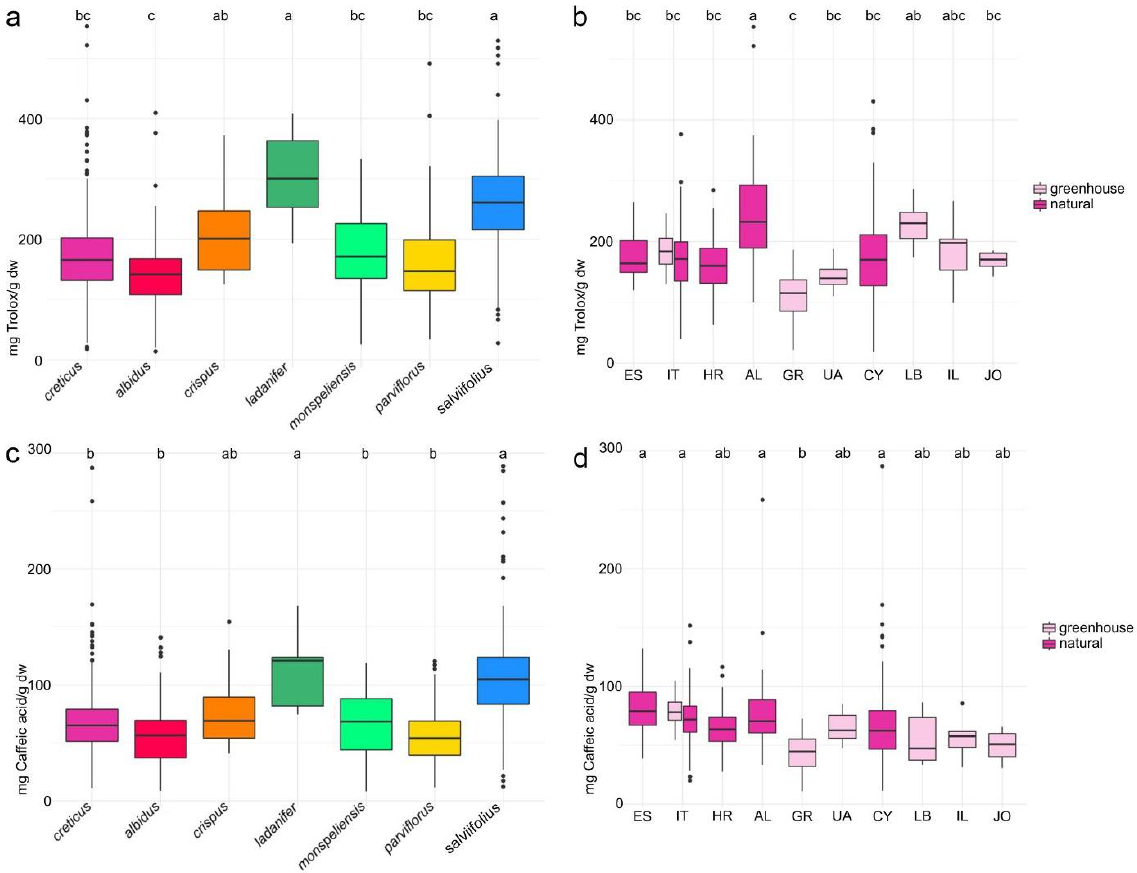
Figure 3. Comparison of ( a ) 2,2-diphenyl-1-picrylhydrazyl (DPPH) radical scavenging activity (mg te/g dry wt) and ( c ) total phenolic content (mg cae/g dry wt) of C. creticus , C. albidus , C. crispus , C. ladanifer , C. monspeliensis , C. parviflorus and C. salviifolius . Species with the same letter on top do not differ significantly from each other (groups were determined by Tukey HSD test, alpha = 0.005). Comparison of ( b ) DPPH radical scavenging activity (mg te/g dry wt) and ( d ) total phenolic content (mg cae/g dry wt) of C. creticus populations originating from Spain to Jordan. Colors determine either species or natural (pink) or greenhouse origin (light pink) of the analyzed plant material. Countries with the same letter on top do not differ significantly from each other (groups were determined by Tukey honestly significant difference (HSD) test, alpha = 0.005). ES = Spain (three populations), IT = Italy (two cultivated populations and eleven natural populations), HR = Croatia (16 populations), AL = Albania (four populations), GR = Greece (four populations), UA = Ukraine (one population), CY = Cyprus (28 populations), LB = Lebanon (one population), IL = Israel (one population), JO = Jordan (one population).